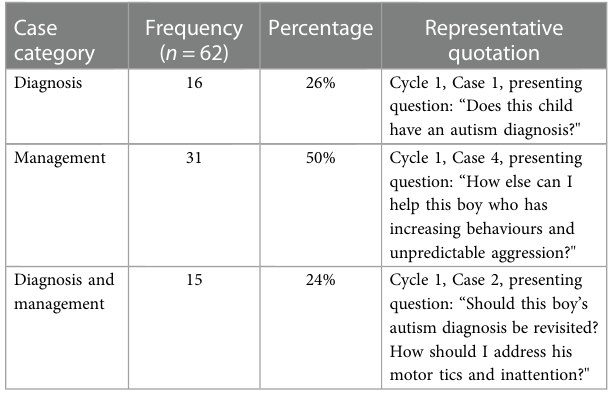
TABLE 3 Primary presenting problem of ECHO Ontario Autism cases.